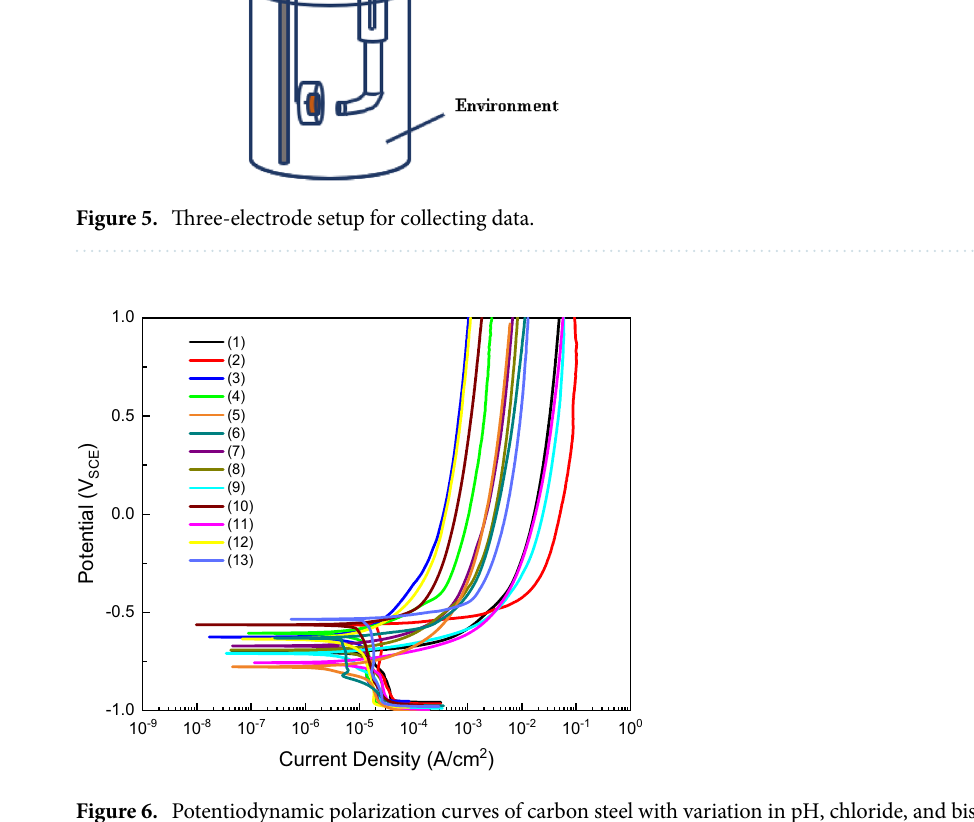
Figure 6. Potentiodynamic polarization curves of carbon steel with variation in pH, chloride, and